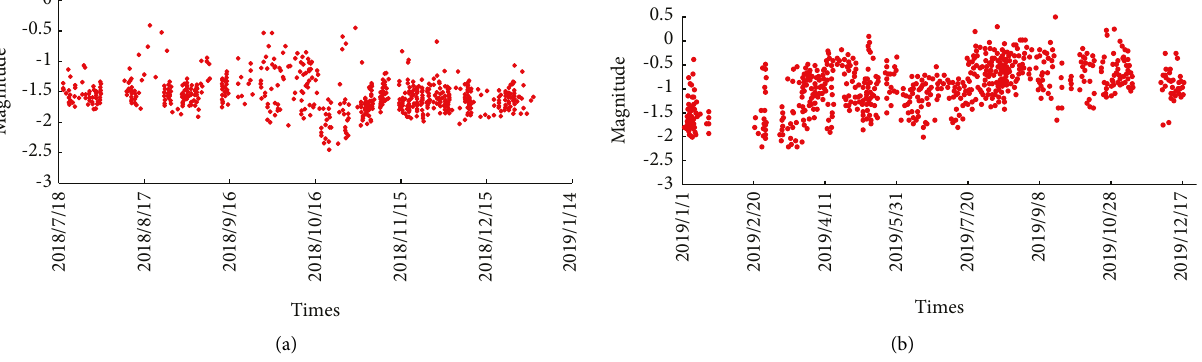
Figure 9: The relationship between the magnitude and time of microseismic events in the main powerhouse. (a) In 2018. (b) In 2019.